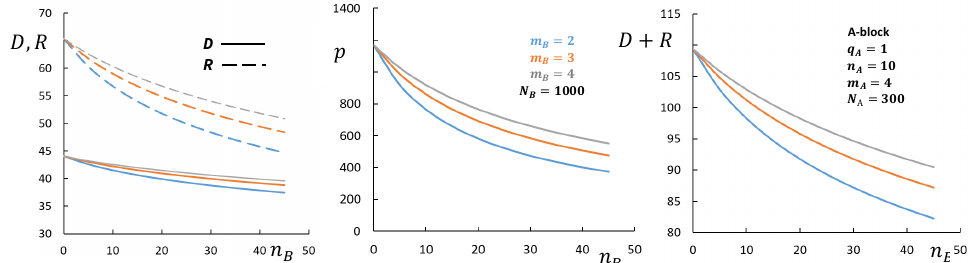
Figure 8. Aggregation number p , core radius, R (dashed lines), corona thickness, D (solid lines), and overall dimensions R + D as a function of the DP n B of side chains in the core forming block at N B = const = 1000. m B is varied, as indicated in the figure. Other parameters are q A = q B = 1 N A = 300, m A = 4, n A = 10 γ = 1, v = 1, φ =